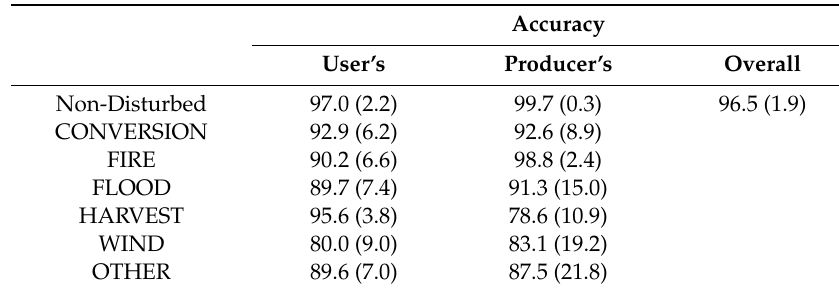
Table 4. Accuracy assessment results for non-disturbed forest and attributed disturbance classes for the Minnesota most recent fast disturbance map (1974–2018). Accuracy uncertainty was calculated as 95% confidence intervals and is reported in parenthesis.